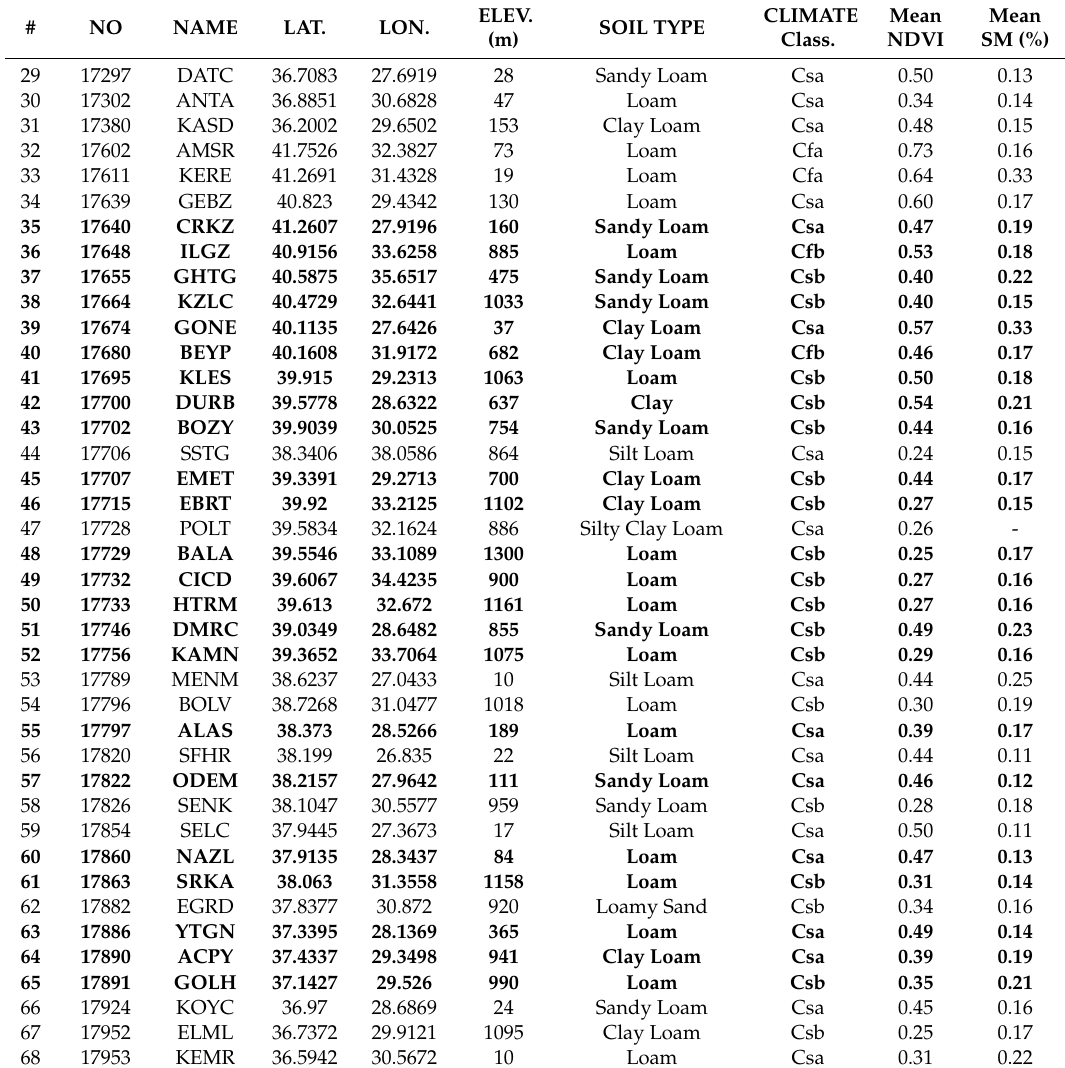
Stations highlighted in bold indicate 40 mutually available